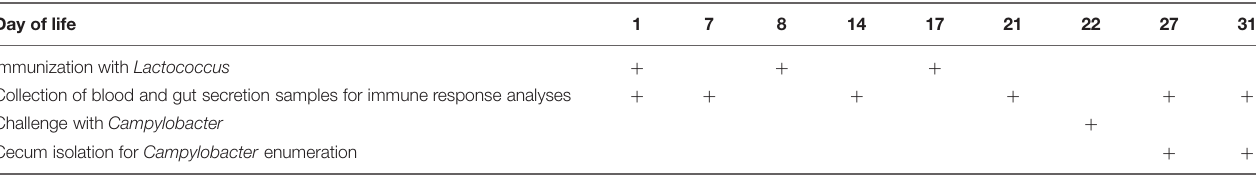
TABLE 3 | Scheme of immune response and protection experiments. Day of